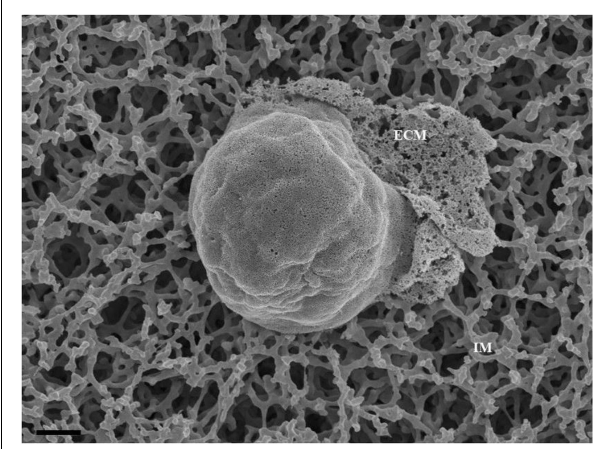
FIGURE 1 | An HRSEM micrographic illustration of a b.End5 cell seeded on a mixed cellulose insert membrane establishing 3-dimensional cellular architecture (Scale bar = 2000 nm). The micrograph exhibits the secretion of a basement like extracellular matrix (ECM). The insert membrane is denoted as “IM.”